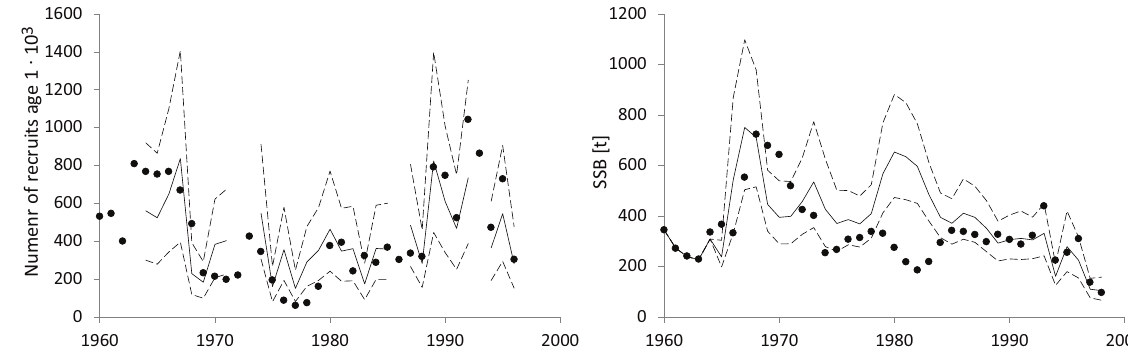
Fig. 2. Number of recruits at age 1 (left) and spawning stock biomass (right) simulated by the pikeperch ( Sander lucioperca ) population model (lines: model results (continuous) with 5% and 95% percentiles (dashed), dots: VPA estimates (Eero 2004, Eero, personal